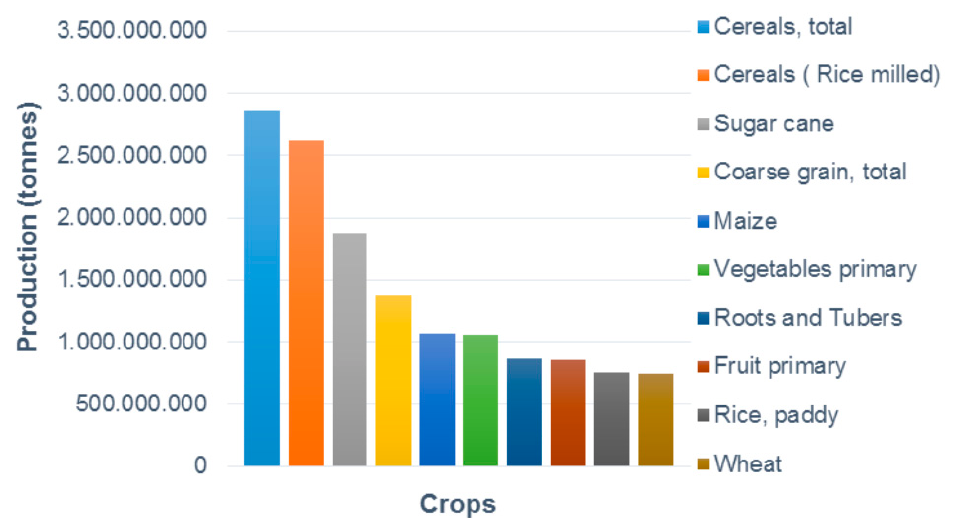
Figure 1. The annual global production of major crops during 2013–2017 (Source: FAOSTAT. www.fao.org. Access on: 06 November 2018).